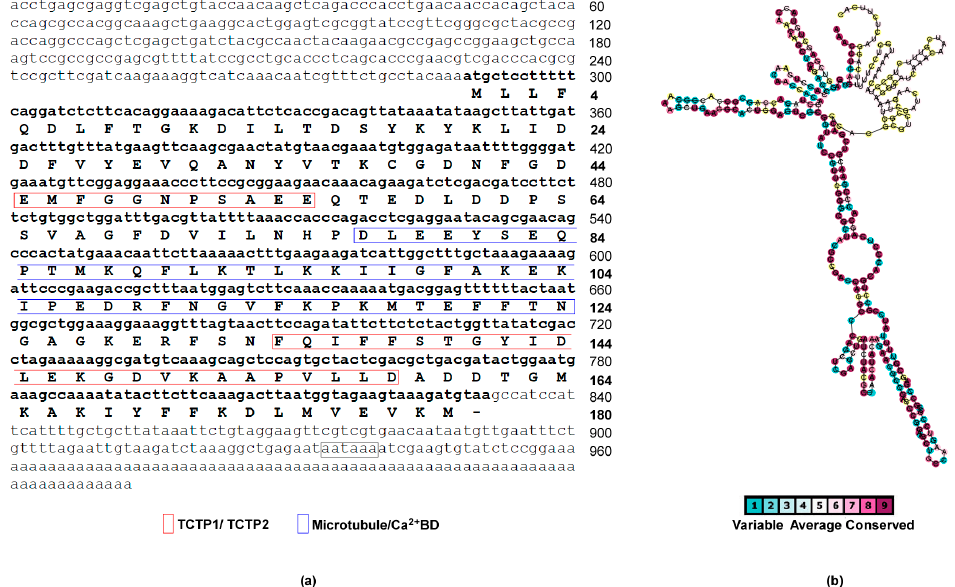
Figure 1. Full-length cDNA and protein sequences characterisation of sea anemone Anemonia